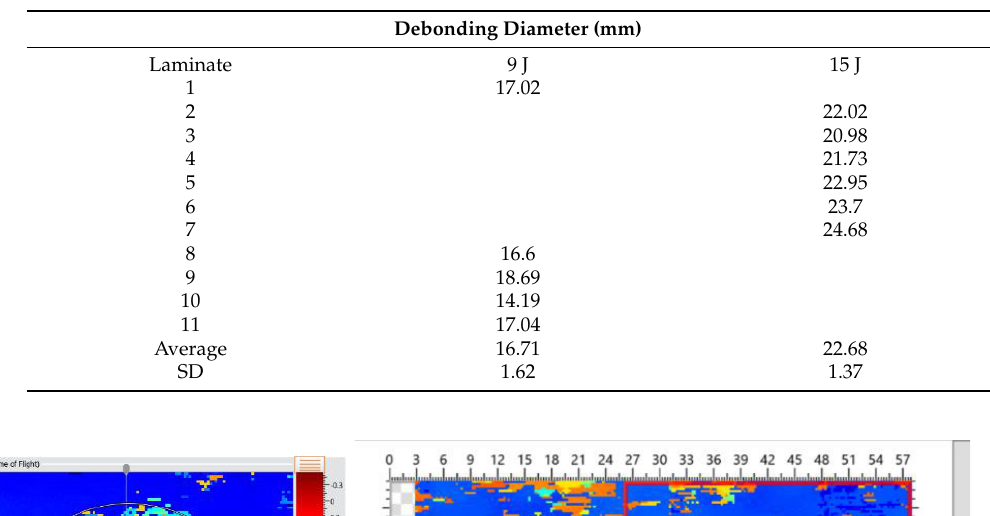
Table 2. Delamination diameters of the impacted RTM6 laminates.